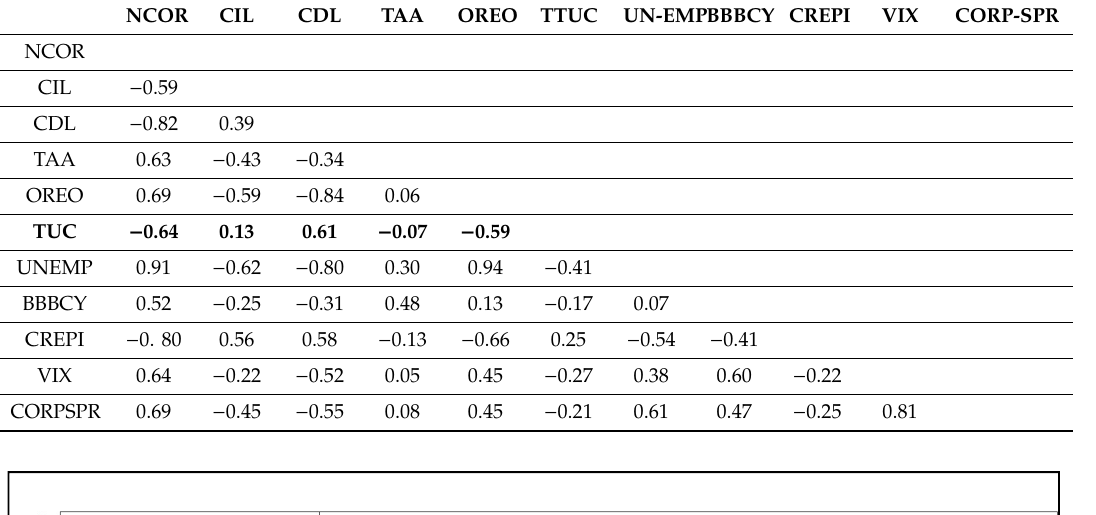
Table 2. Correlations of historical Y9 credit loss rates, banking system idiosyncratic variables, and